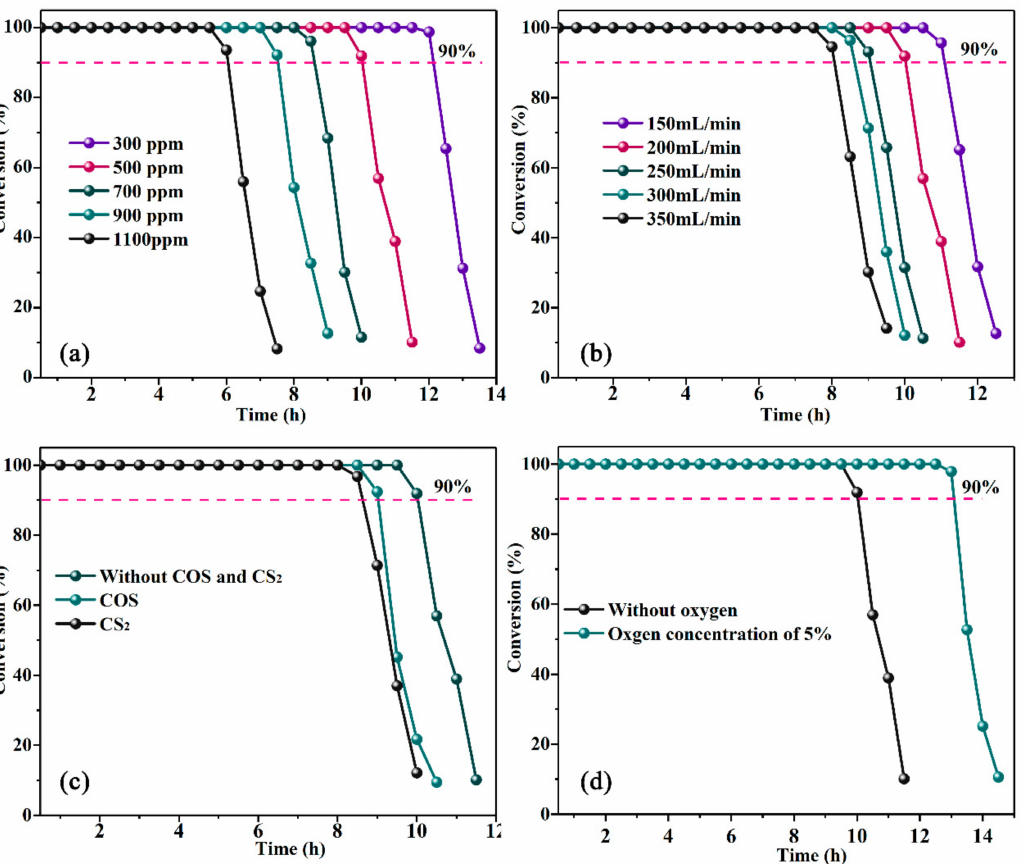
Figure 1. The H 2 S conversion in different reaction condition: ( a ) Gas flow rate = 150–350 mL/min. ( b ) H 2 S concentration = 300–1100 ppm. ( c ) with COS or CS 2 . ( d ) with or without 5% O 2